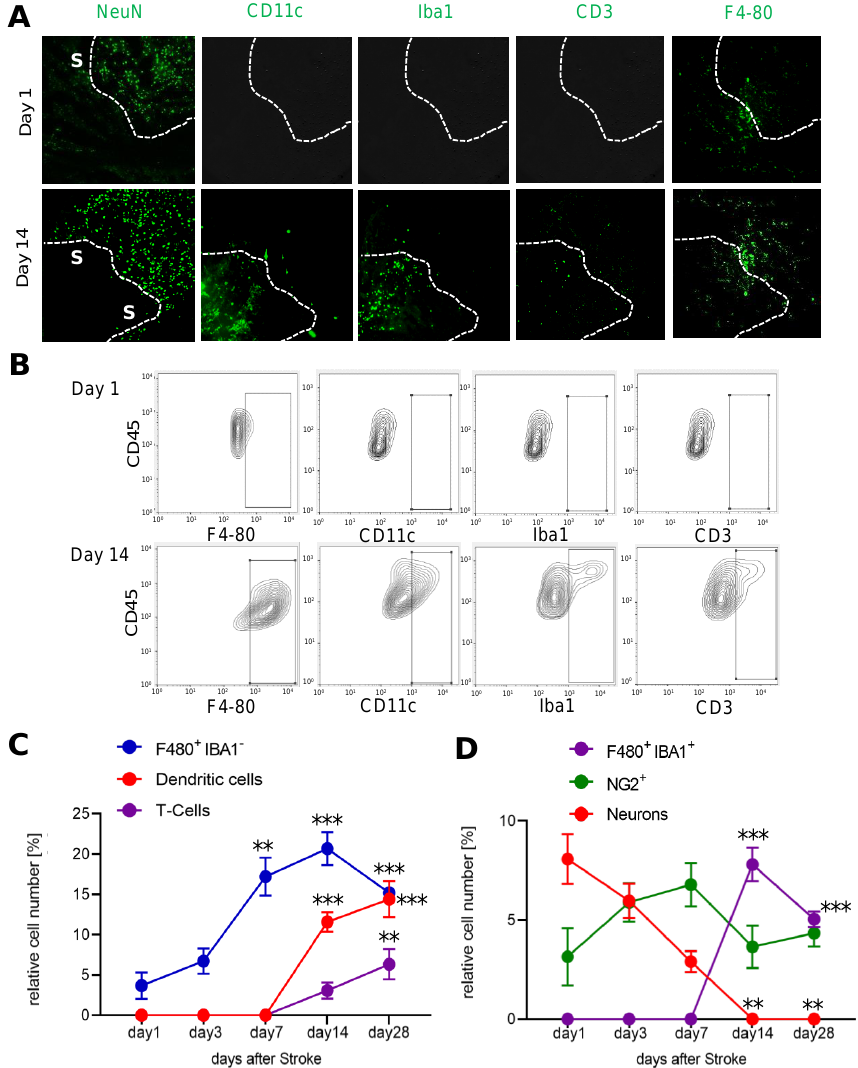
Figure 4. Analysis of immune cell recruitment to the stroke area. ( A ) Representative MELC images showing stroke-affected (S) and unaffected areas at day 1 and 14 after stroke induction. The white lines depict the borders between the two areas. The white bar represents 100 µ m. ( B – D ) Quantitative analysis of immune cells based on the MELC images using flow cytometry standard format in the stroke-affected regions. Data are shown as mean ± S.E.M. (n = 4). One-way ANOVA/Bonferroni ** p < 0.01; *** p <